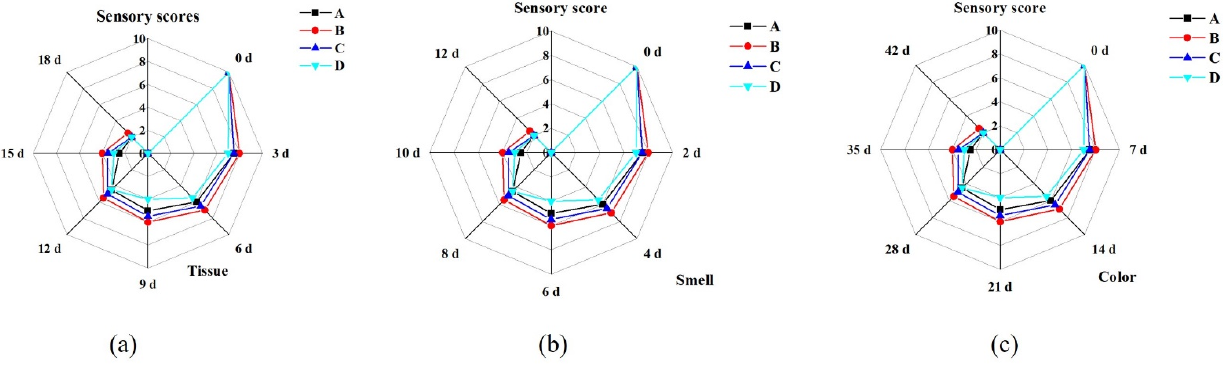
Figure 2. Sensory changes in tissue ( a ), smell ( b ), and appearance ( c ) of sweet corn during storage by four different freezing methods. (A: Ultrasound ‐ assisted freezing, B: Brine freezing, C: Strong wind freezing, D: Refrigerator freezing).